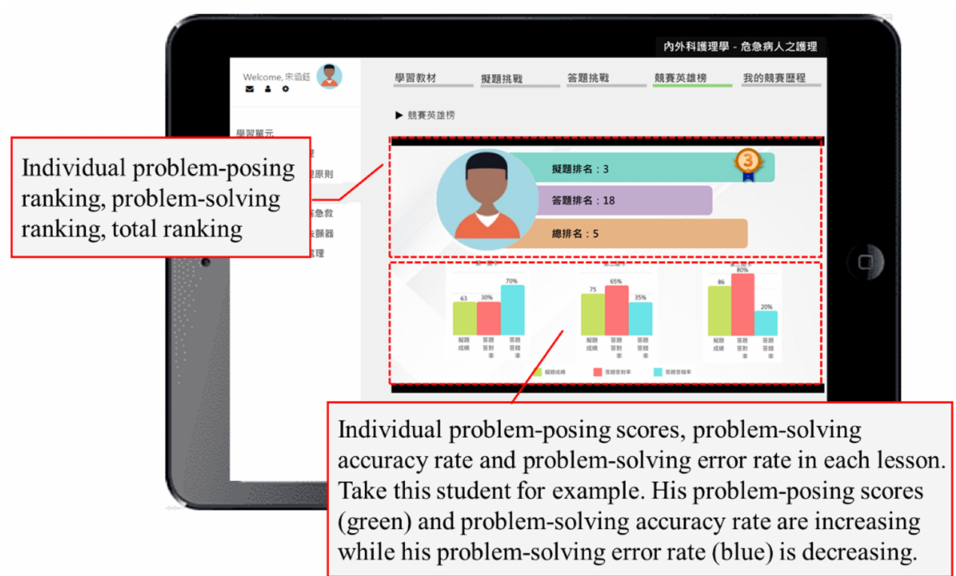
Figure 4. Leaderboard for the problem-posing